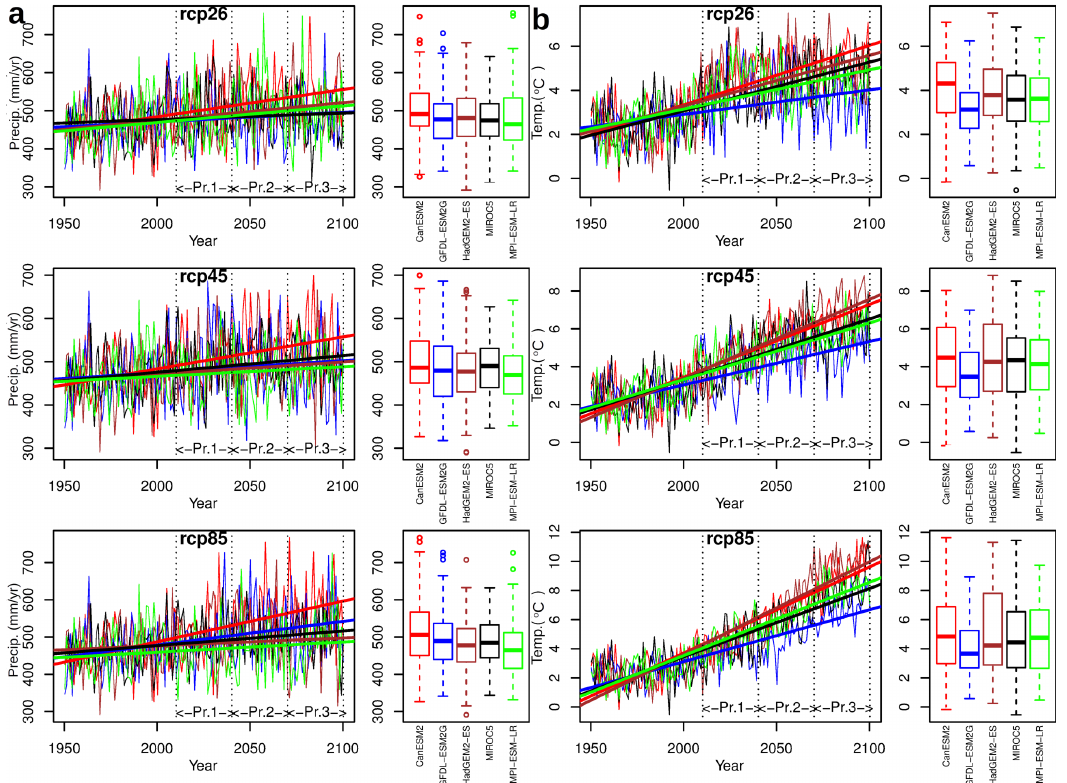
Figure 2. Spatially-averaged time series of PCIC ( a ) annual-averaged precipitation and ( b ) annual-averaged air temperature data for the SSR basin for three RCPs and five GCMs. Colored straight lines, which match boxplot colors, indicate GCM’s linear trends and dotted vertical lines indicate the three SPARROW modelling periods Pr.1 (2010–2039), Pr.2 (2040–2069) and Pr.3 (2070–2099). GCM’s box plots, grouped by RCPs for the 1950–2099 period, show 25, 50 (median) and 75 percentiles box plot whiskers represent upper and lower extremes. Outliers are also included in the box